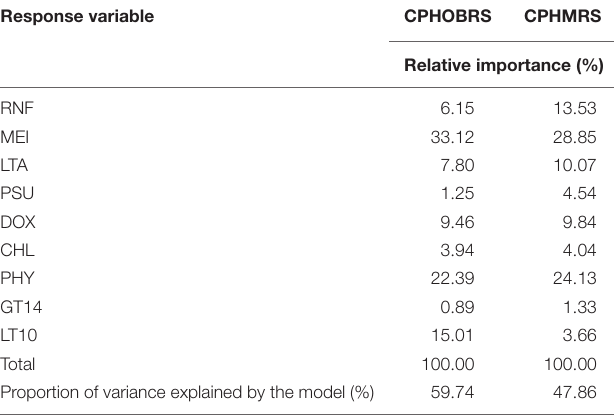
TABLE 5 | Percentage of variance in CPUE (CPHOBRS and CPHMRS) explained by the parameters rainfall (RNF), multivariate ENSO index (MEI), local thermal anomaly (LTA), salinity (PSU), dissolved oxygen (DOX), chlorophyll a (CHL), phytoplankton (PHY), greater than 14 mm fish (GT14) and less than 10 mm fish (LT10) and the percent contribution of each variable to the fitted regression